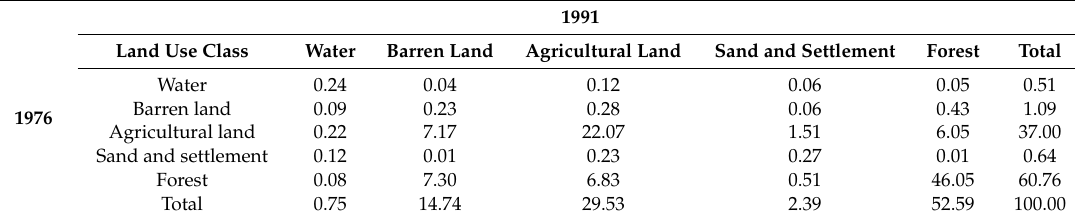
Figure 5. Comparison of land use and land cover (LULC) class in the years 1976, 1991, and 2015. Table 3. Land use land cover change dynamics from 1976–1991 (in %).